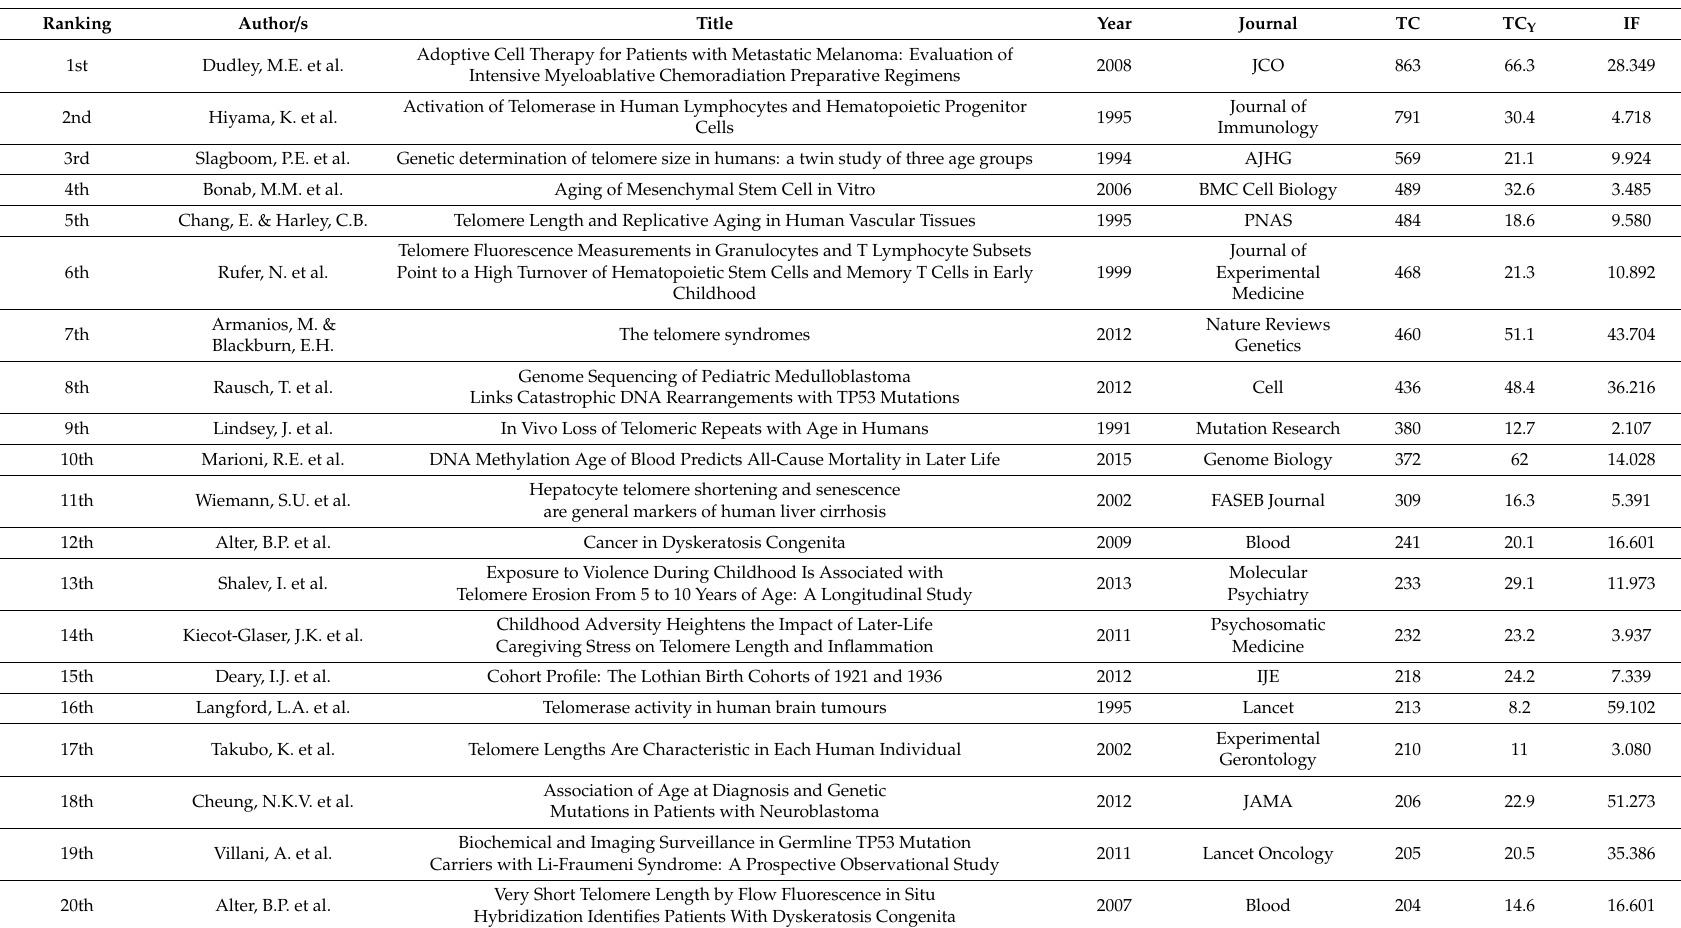
Table 5. Top 20 most cited research papers on telomere length in